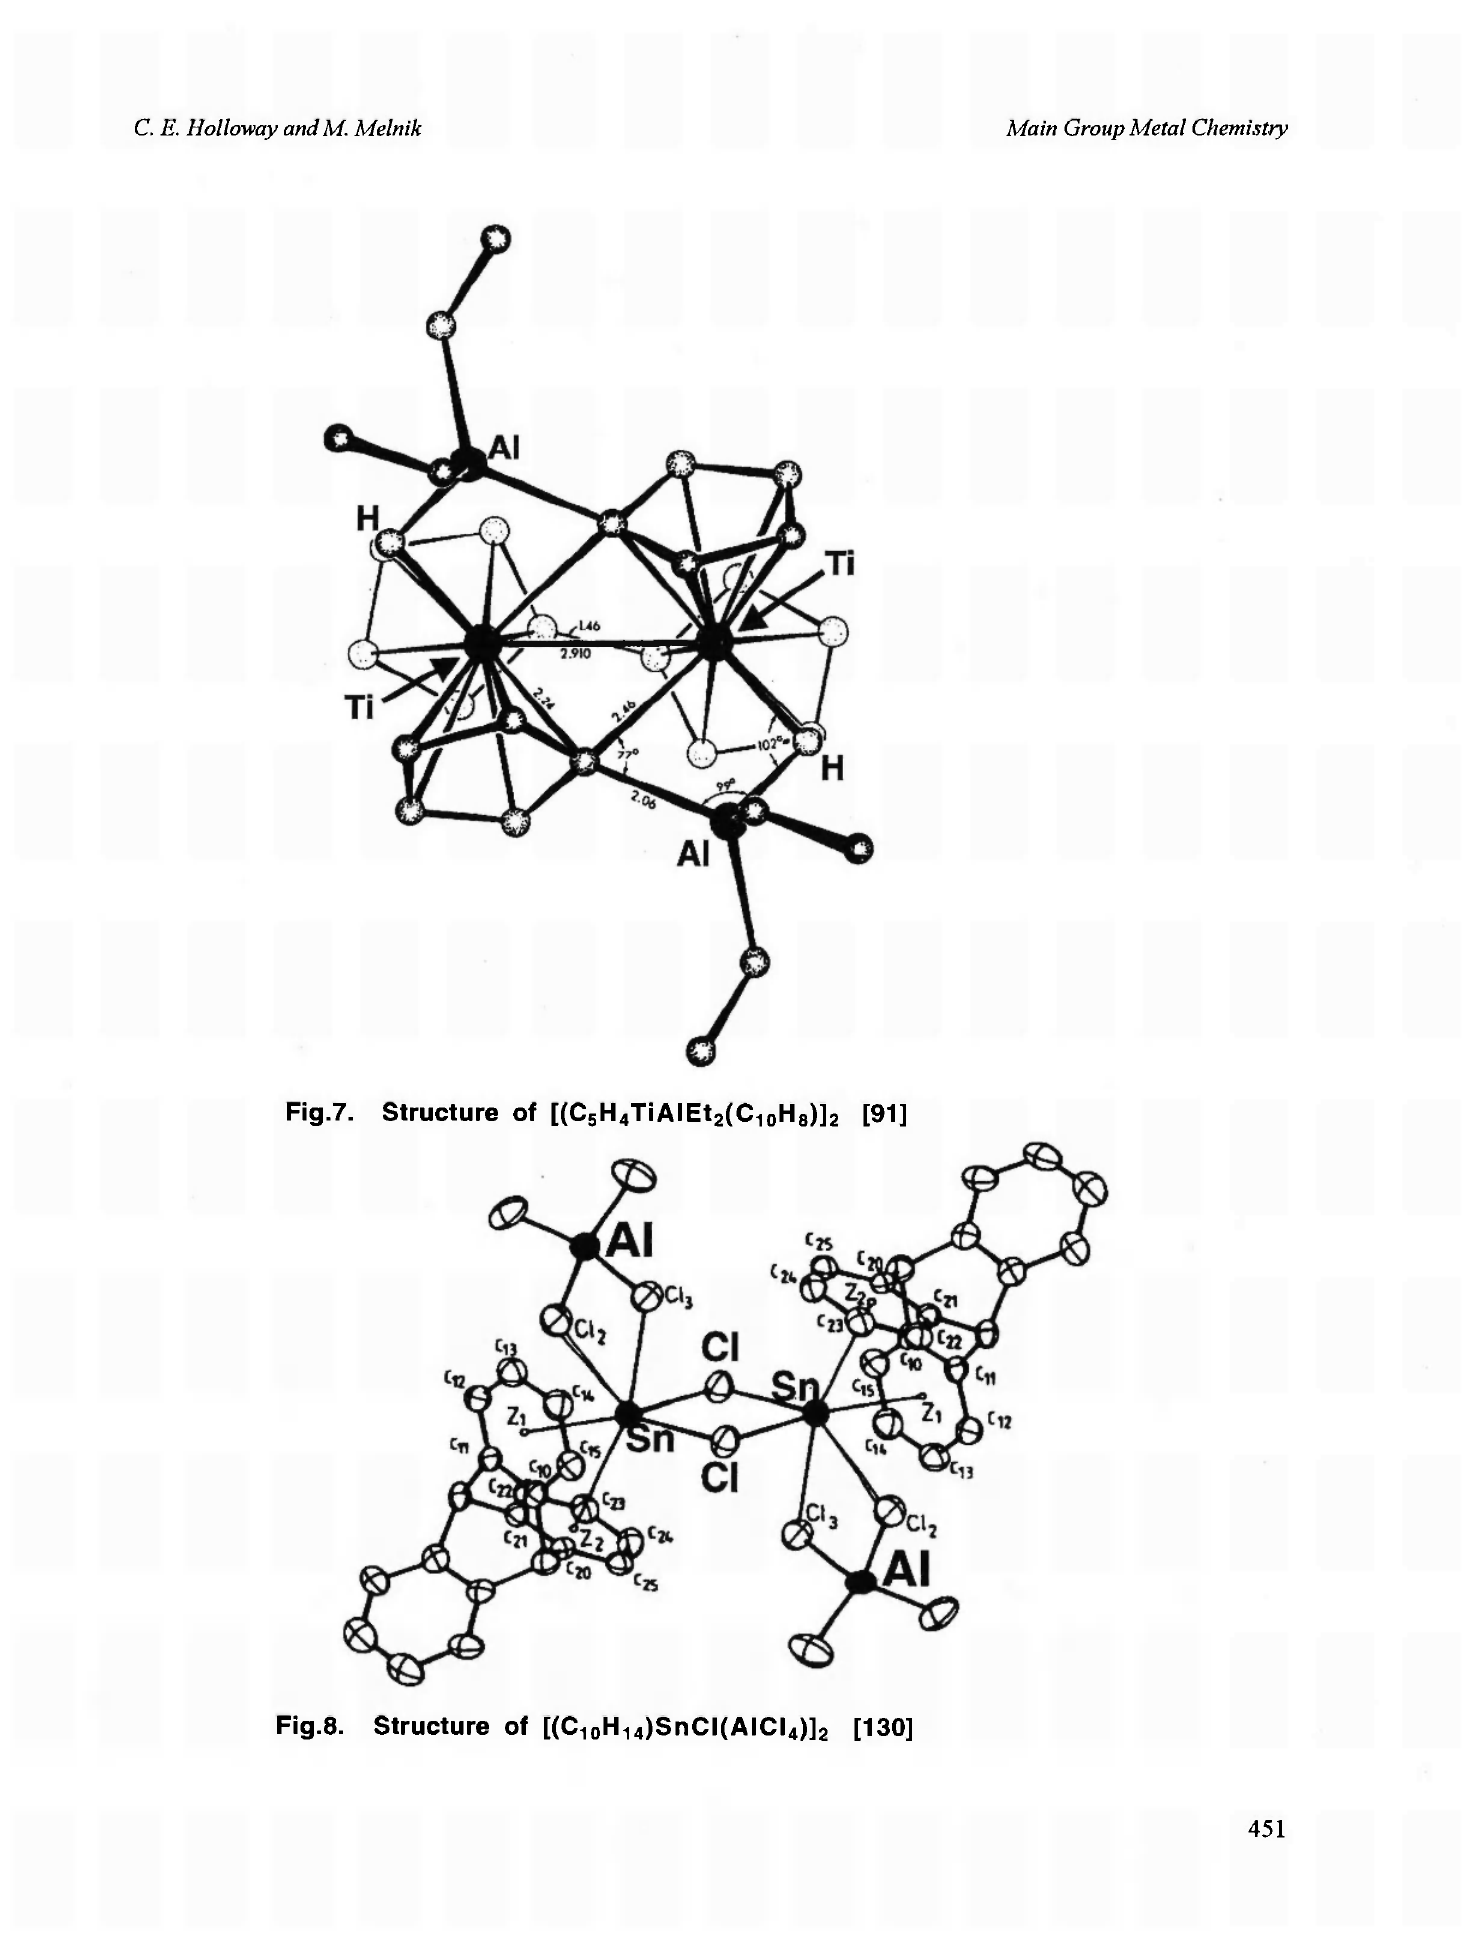
Fig.8. Structure of [ ( C 1 0 H 1 4 ) S n C I ( A I C l 4 )